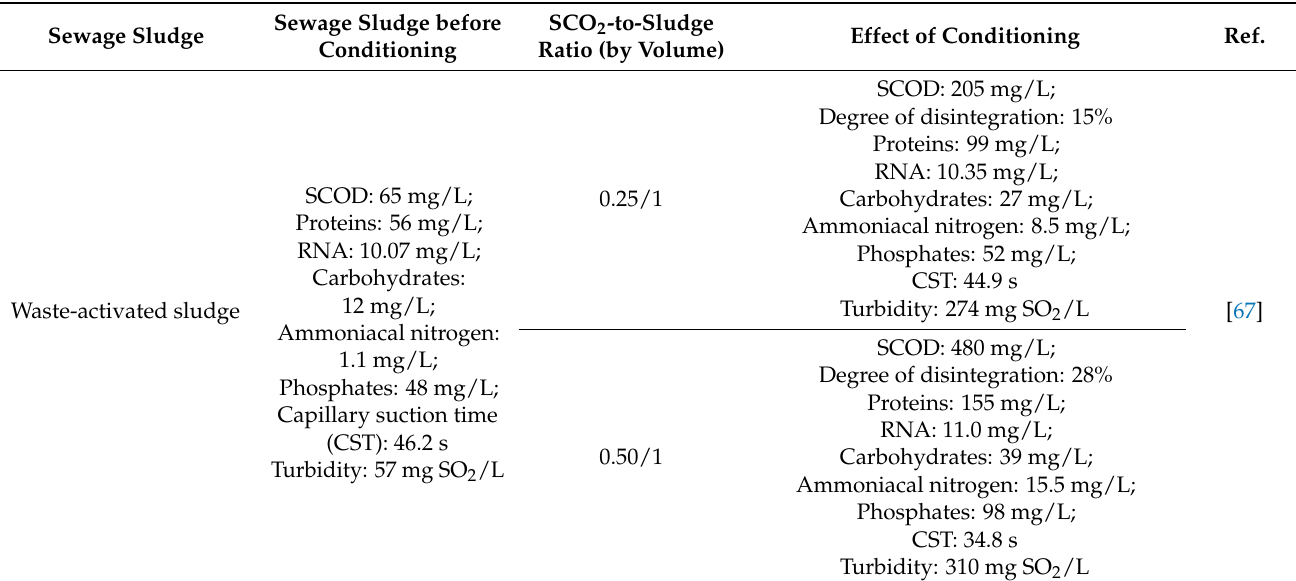
Table 6. Effect of conditioning with SCO 2 on